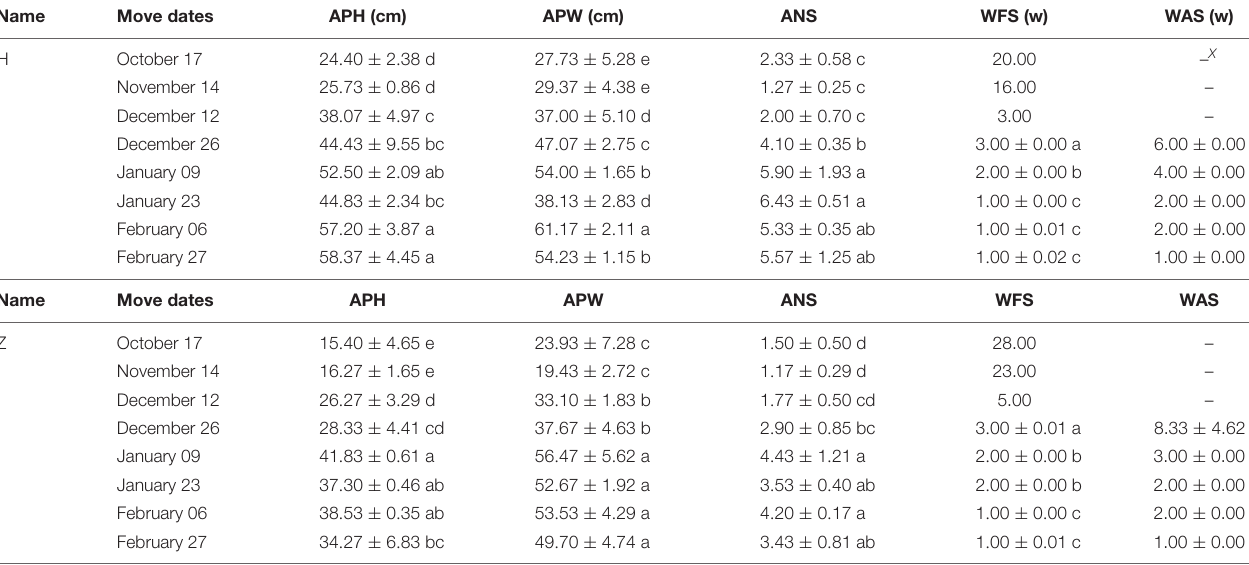
TABLE 3 | Morphological observations of the two cultivars after moved into glasshouse under natural chilling treatments in 2018–2019.